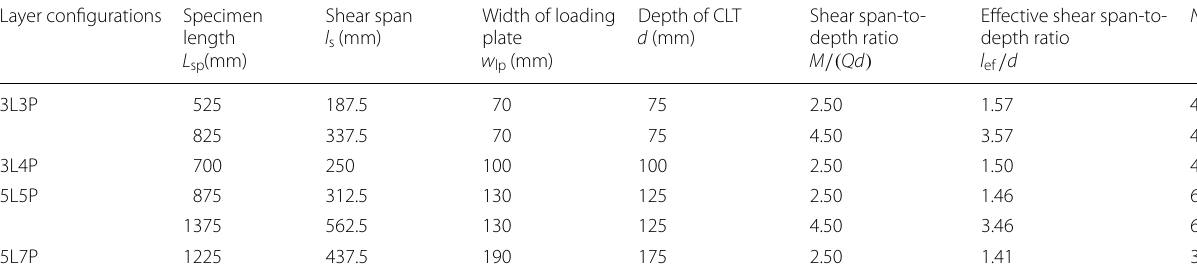
Table 2 Loading conditions for three-point bending tests Layer configurations Specimen length